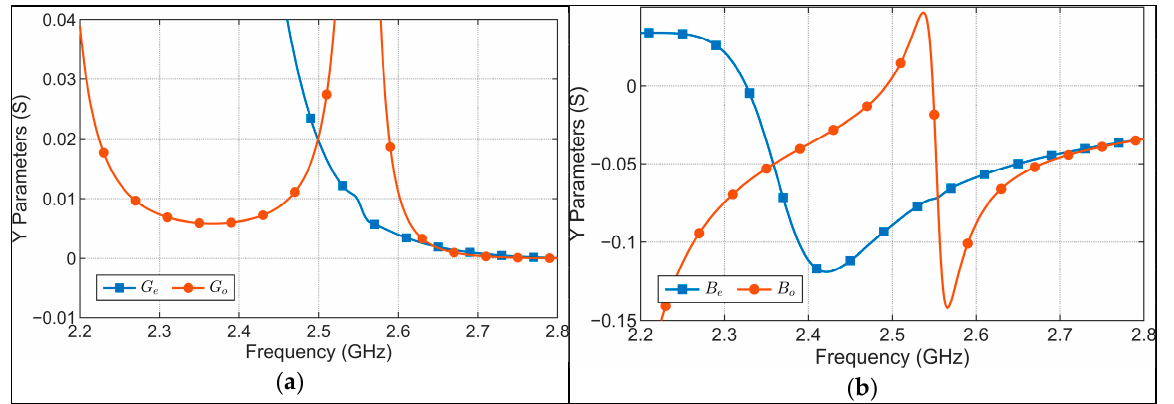
Figure 8. Y parameters at the reference plane t 2 : ( a ) real part of the even and odd admittances; and ( b ) imaginary part of the even and odd admittances.